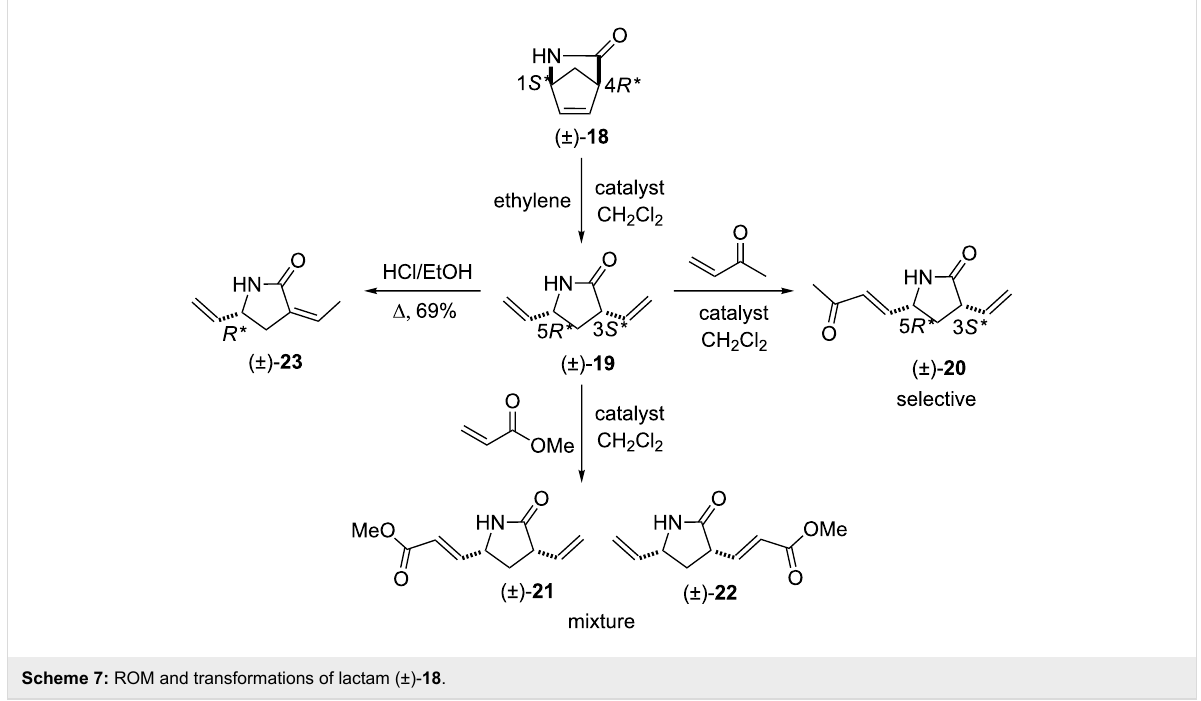
Scheme 7: ROM and transformations of lactam (±)- 18 .